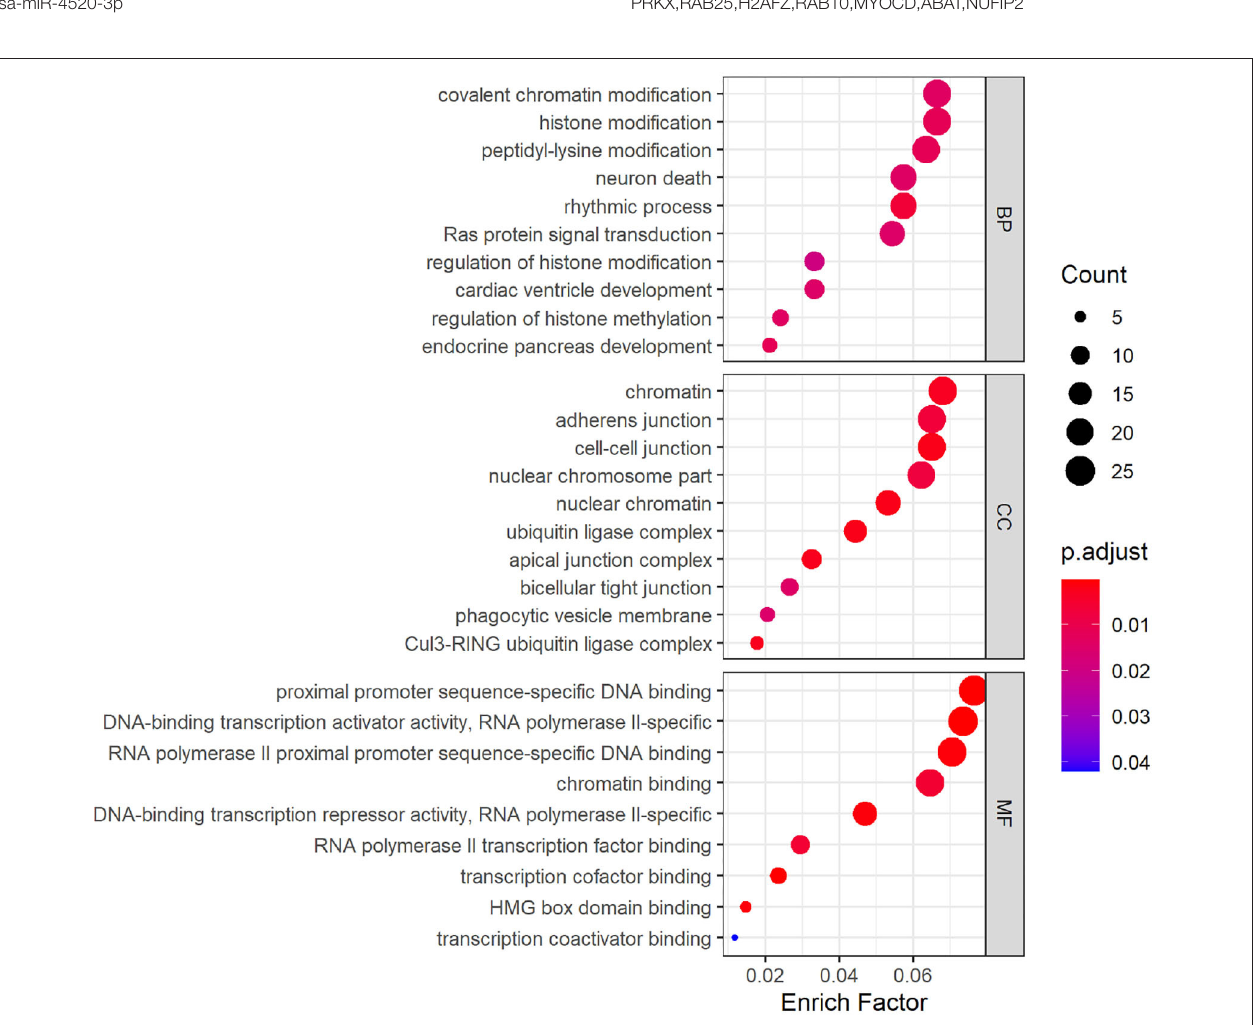
FIGURE 5 | Gene ontology (GO) analysis dotplot of hsa_circ_0008234.